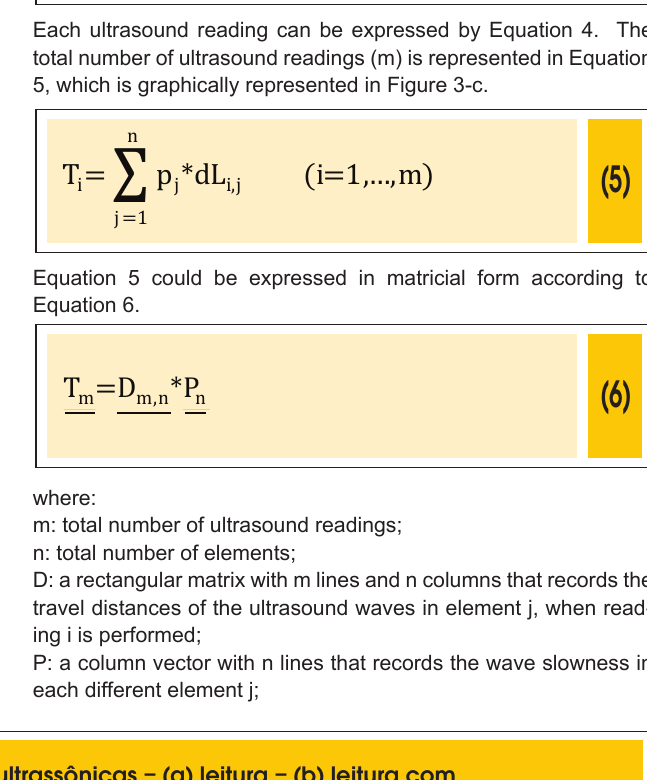
Figura 3 – Representação das leituras ultrassônicas – (a) leitura – (b) leitura com elementos discretizados – (c) várias leituras com elementos